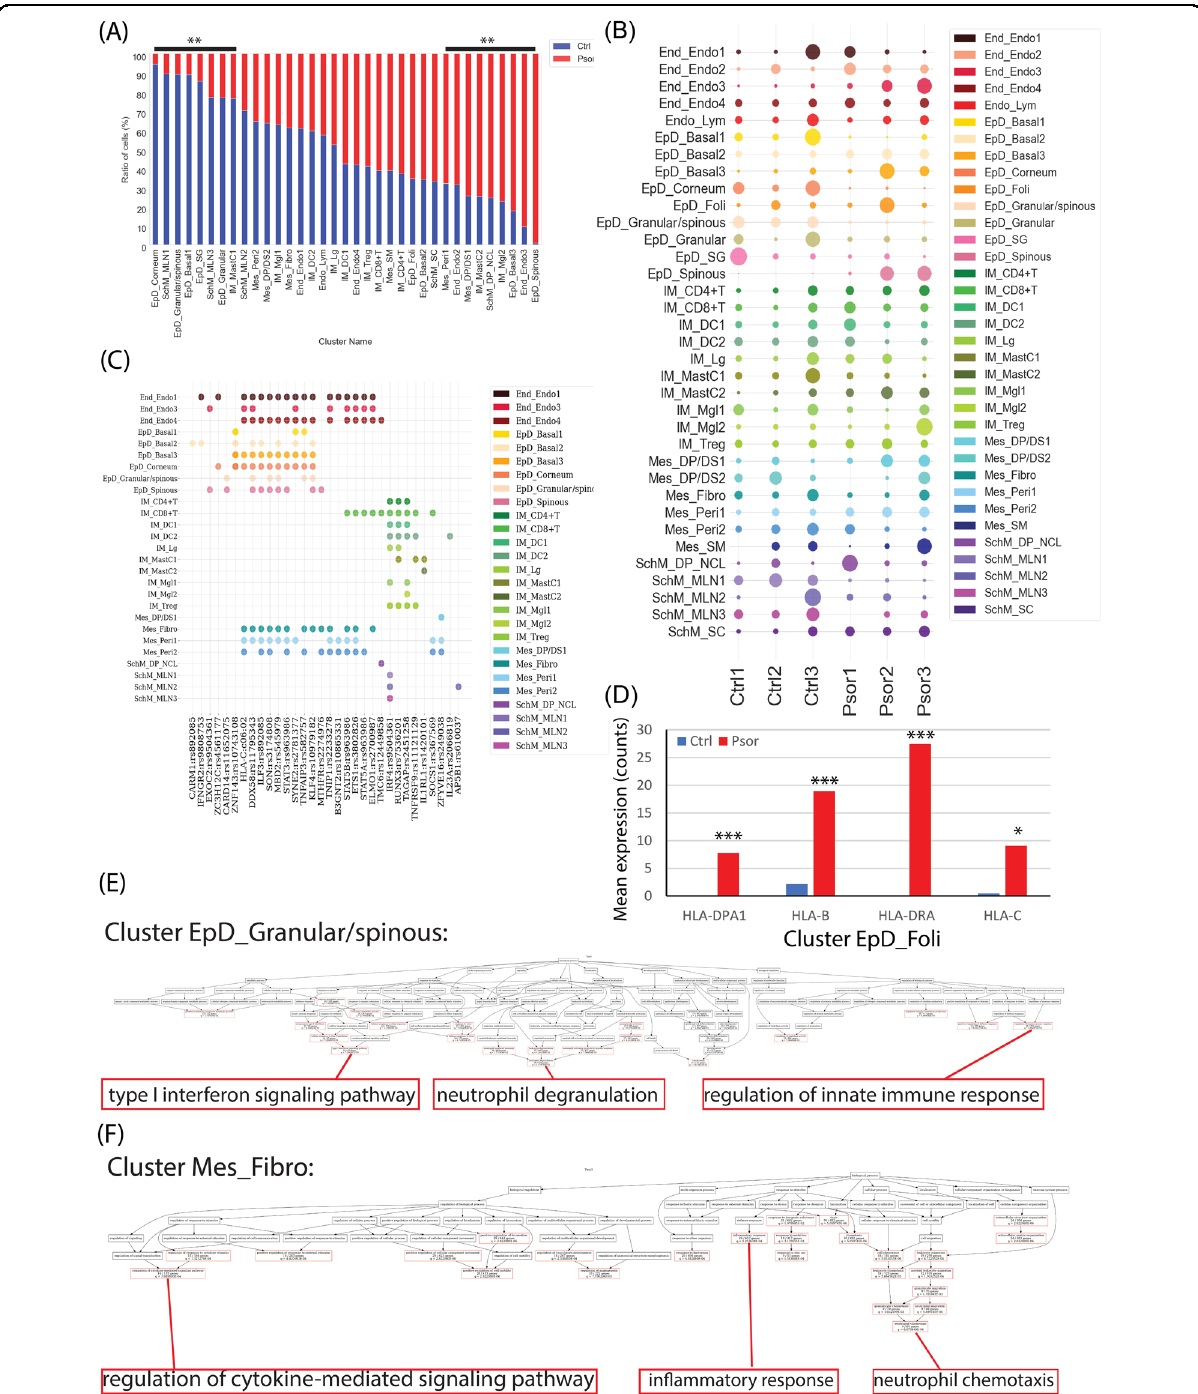
Fig. 3 The difference of cellular composition and cell-type-based transcription in psoriasis. A Percentage bar plot of cell type composition in healthy and psoriatic skin, y- axis represented the percent of total cell number of that cell type. Red color represented psoriatic skin and blue color represented healthy control skin. Signi fi cant changes (FDR < 0.01) were labeled as ** on the top. B Dot plot of cell number distribution of each cell type in each healthy and psoriasis donor. Dot size represented the cell number percent of that donor ( x- axis) in that cell type ( y- axis). Color indicated the cell types. C Dot plot of the signi fi cant existence of each susceptibility gene loci ( x- axis) in each cell type ( y- axis). Color indicated each cell type. D Bar plot of the raw counted of four selected HLA genes in cell type EpD_Foli. Red color represented psoriatic skin and blue color represents healthy control skin. Y- axis represents the mean value of the expression raw counts. ***, FDR p < 0.001; *, p < 0.05. E , F GO-bioprocess enrichment plot of all psoriasis upregulated genes in cell type EpD_Granular/spinous (E) and Mes_Fibro (F). Red frame highlighted the signi fi cant enriched GO terms and the terminally enriched GO-bioprocess were enlarged at the bottom of each